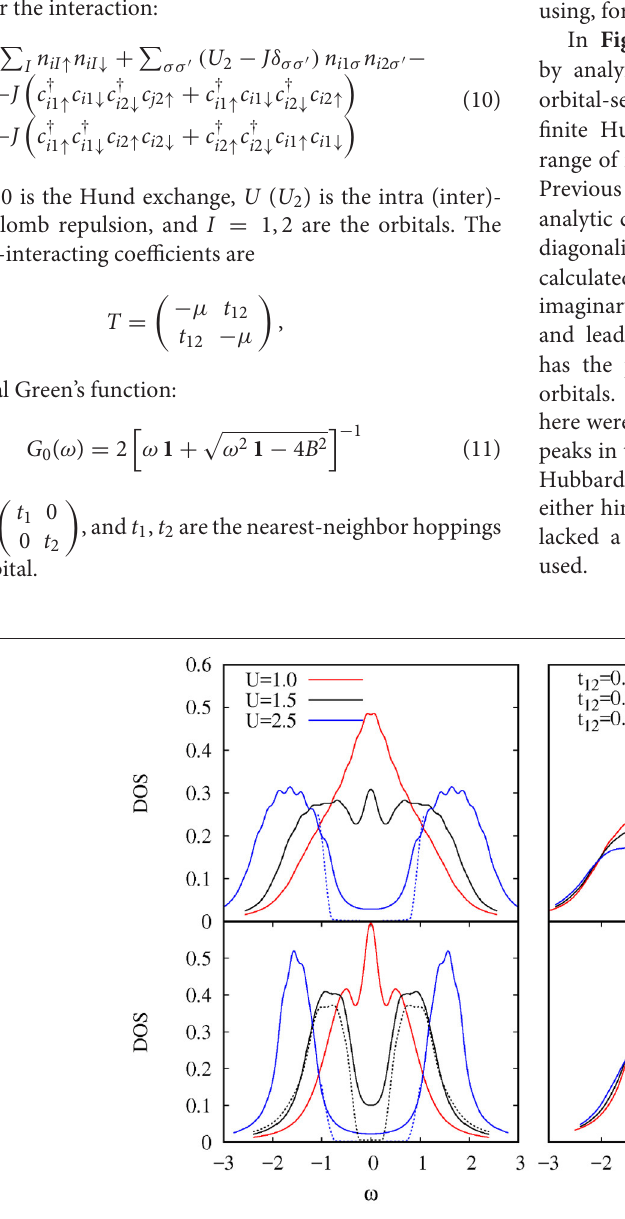
FIGURE 2 | DOS for the half-filled two-band Kanamori-Hubbard model on the Bethe lattice showing the orbital-selective Mott transition for different bandwidths: t 1 0.5 (Top panels) and t 2 0.25 (Bottom panels) . (Left panel) varying U for t 12 = = U U / 4. Two different values of the broadening η are depicted to emphasize the gapped region for the insulating phase. invariant case U 2 2 J and J = − =